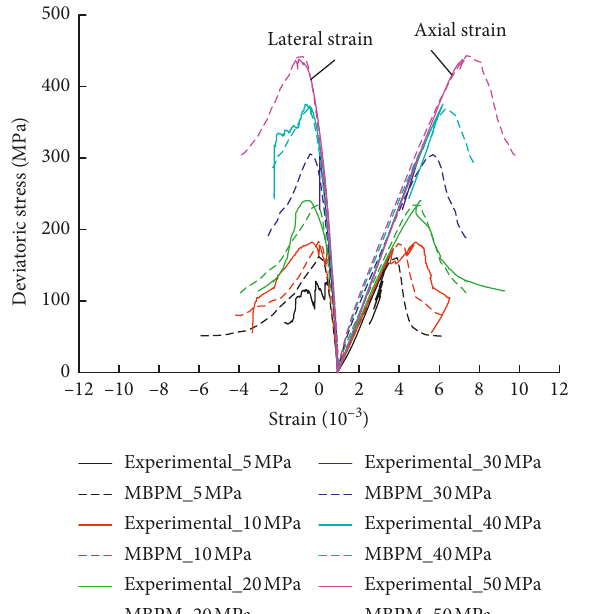
Figure 19: Comparisons of deviatoric stress-strain curves from the experimental results and numerical results of triaxial compression tests.